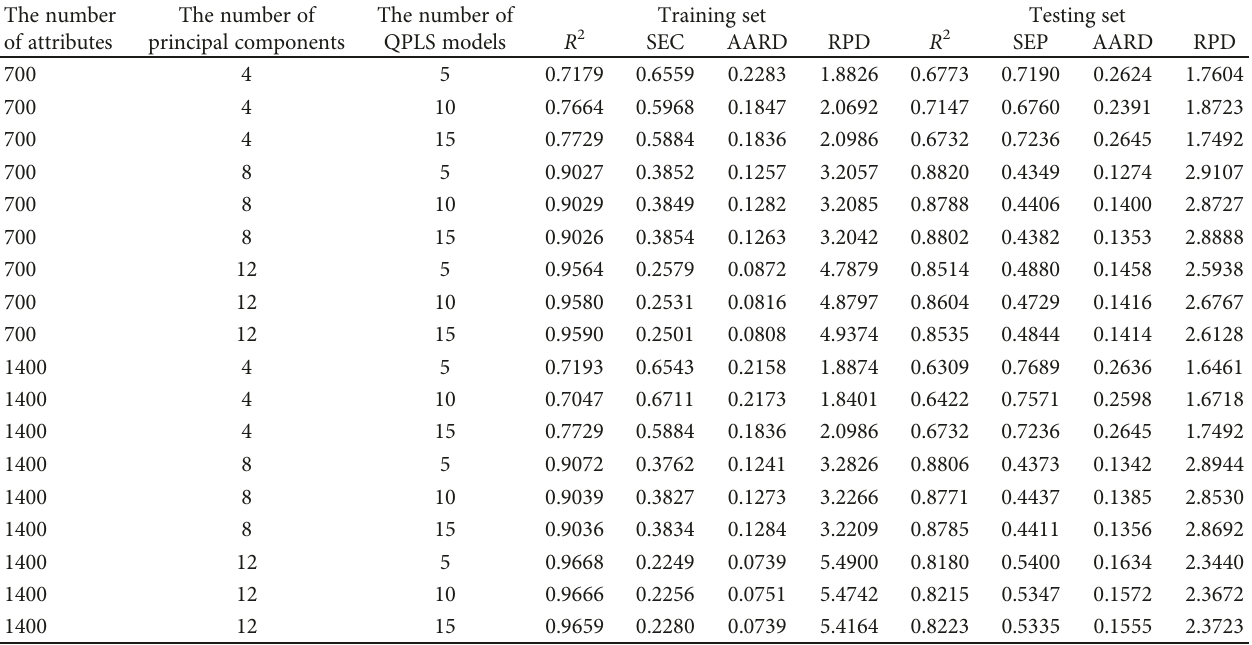
Table 2: The results of the k QPLS-SVR models for quanti fi cation of the relative content of Pst DNA in wheat leaves in the incubation period built with the original near-infrared spectra.